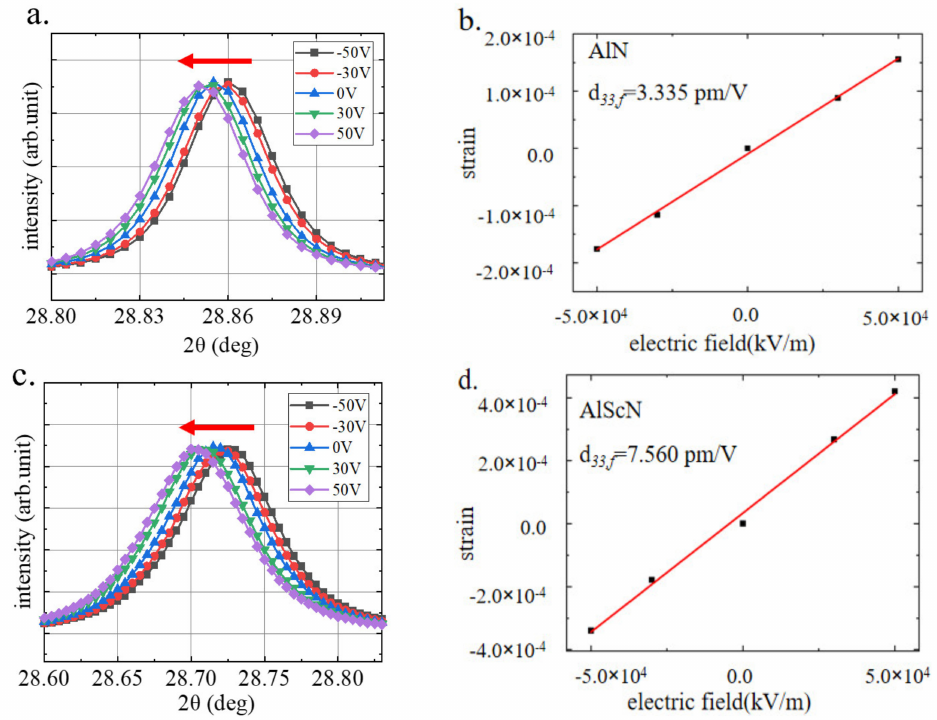
Figure 6. Out-of-plane XRD patterns of the ( a ) AlN and ( b ) AlScN thin films obtained for the (002) peak under varying DC voltages; The d 33, f linear fit results of ( c ) AlN and ( d ) AlScN thin